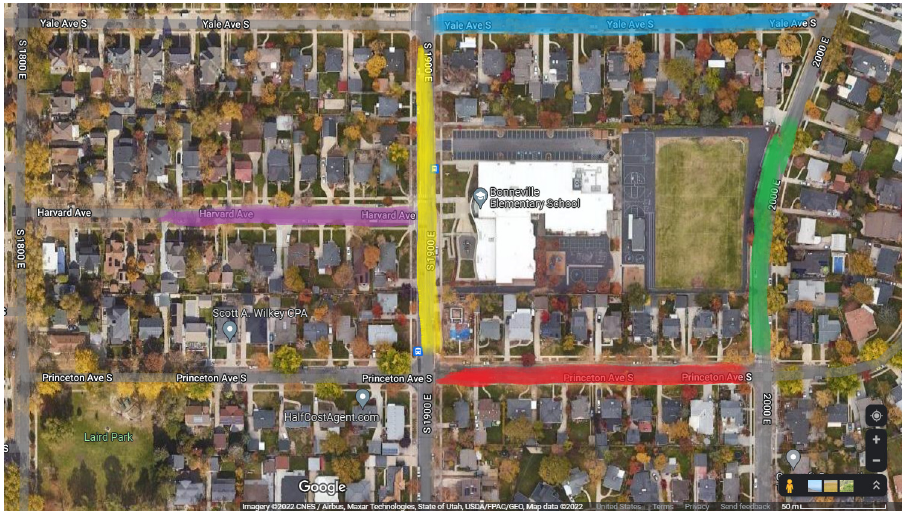
Figure 3. Bonneville Elementary School Vehicle Counting Site locations. Volunteers counted the total number of vehicles, number of idling vehicles, and total time idling for each vehicle at the following highlighted streets: 1900 E (yellow), 2000 E (green), Harvard Avenue (purple), Yale Avenue (blue), Princeton Avenue (red). Image courtesy of Google Maps.